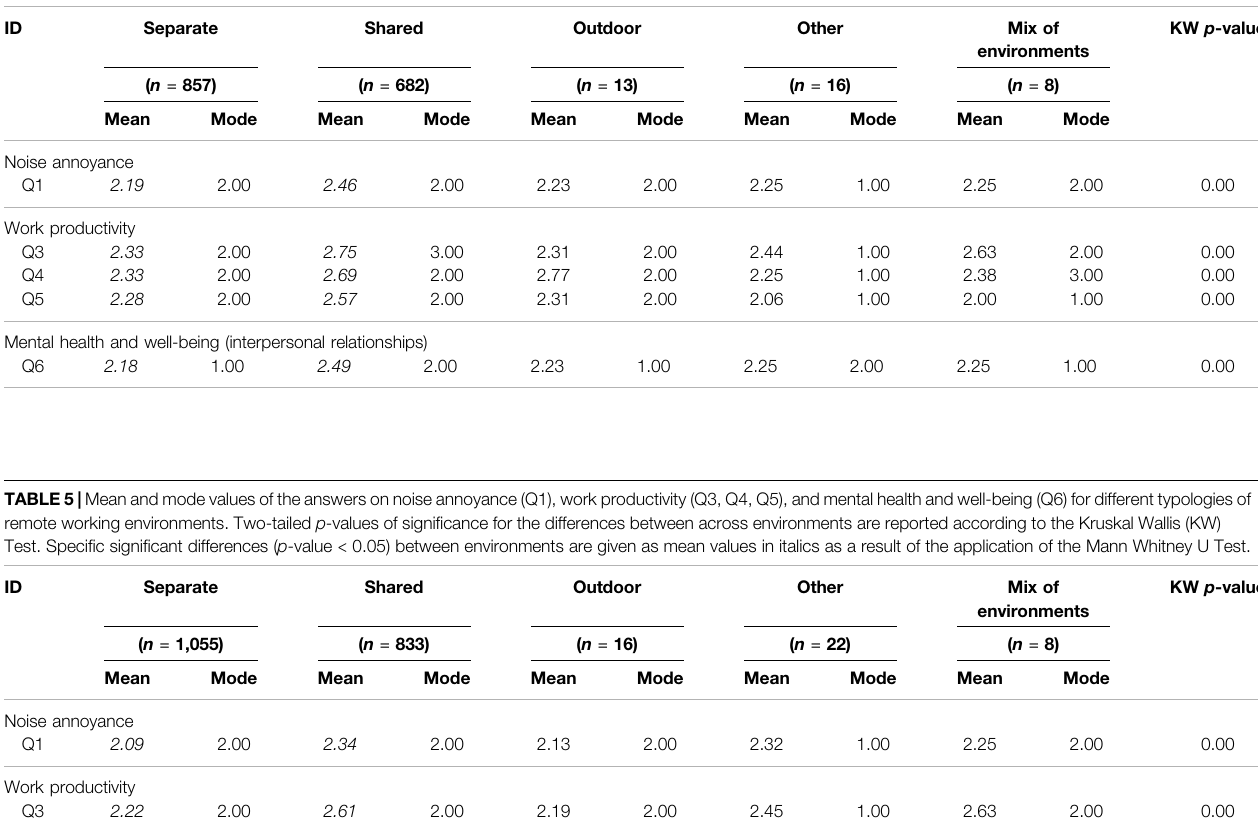
TABLE 4 | Mean and mode values of the answers given by sensitive ( n (cid:1) 1,576) to noise respondents on noise annoyance (Q1), work productivity (Q3, Q4, Q5), and mental health and well-being (Q6) for different typologies of remote working environments, considering. Two-tailed p -values of signi fi cance for the differences between across environments are reported according to the Kruskal Wallis (KW) Test. Speci fi c signi fi cant differences ( p -value < 0.05) between environments are given as mean values in italics as a result of the application of the Mann Whitney U Test.